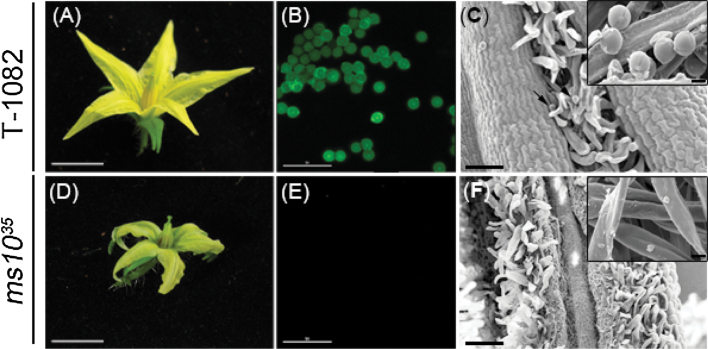
Flower phenotypes and pollen production in T-1082 (male fertile) and the ms10
35 mutant. (A, D) Flowers of T-1082 (A) and ms10
35 plants (D). (B, E) FDA assay for pollen viability of T-1082 (B) and ms10
35 (E) plants. Pollen grains or dust particles released from anthers at the dehiscence stage were used. (C, F) SEM observation of the surfaces of anthers at the dehiscence stage from T-1082 (C) and ms10
35 (F) plants. The insets show a closer look at the surface of the anthers. The T-1082 anther produced pollen grains (arrow and inset). Bars, 0.5cm (A, D); 100 µm (B, C, E, F); 10 μm (insets). (This figure is available in colour at JXB online.)